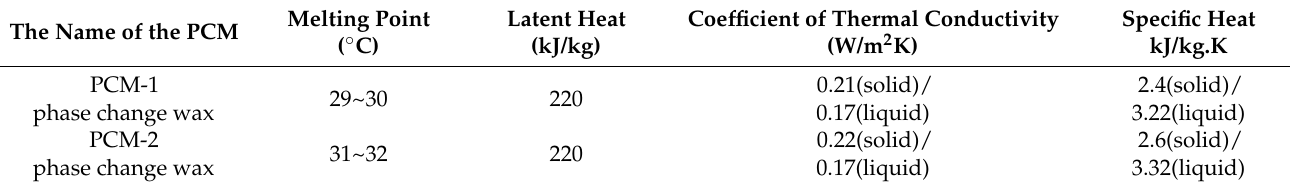
Table 2. Main physical parameters of PCM-1 and PCM-2 phase change wax.